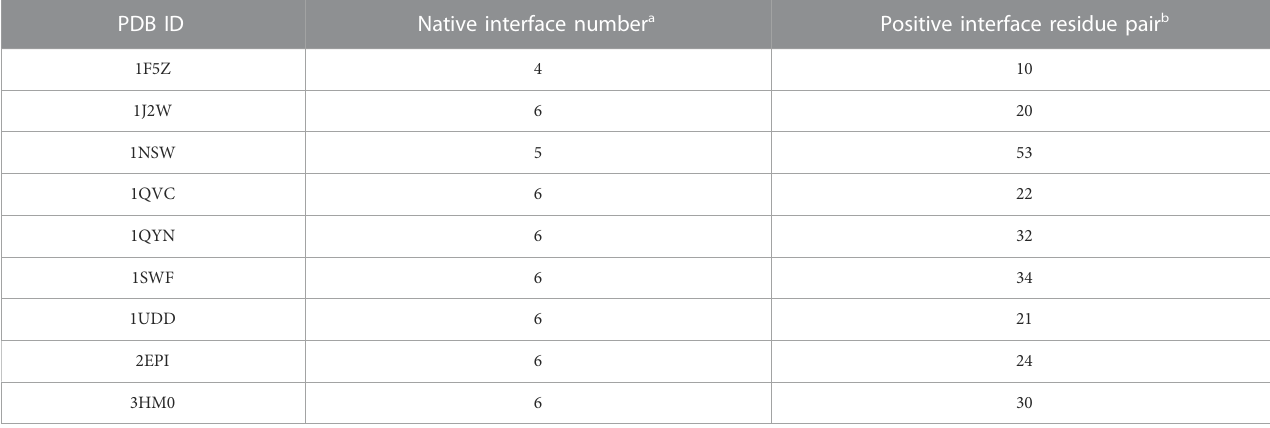
TABLE 7 Predictions of 9 tetramer protein complexes in testing